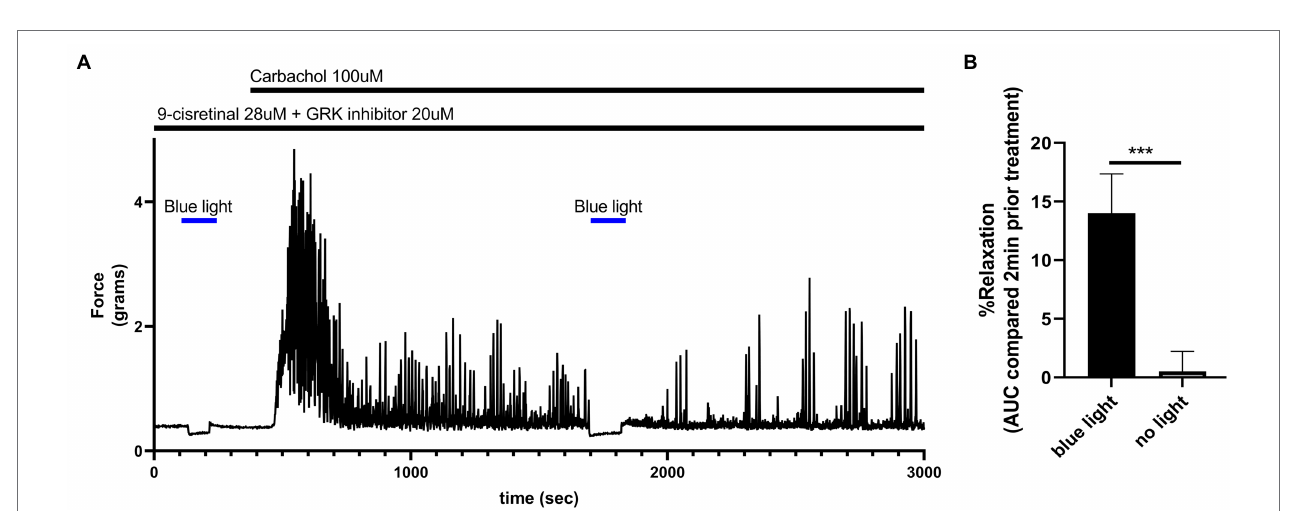
FIGURE 7 | (A) Representative force tracing of colonic rings pretreated with 9- cis retinal 28 μ M + GRK2 inhibitor 20 μ M and constricted with 100 μ M carbachol. Pretreatments depicted by the black bars. Blue bar depicts a 2 min 435 nm blue light treatment. Blue light treatment prior to constriction depicts the effects of blue light on resting tension. The second blue light treatment was to demonstrate the maintenance of post-contractile relaxation. (B) Area under the curve analysis of blue light-induced photorelaxation of rings at resting tension vs. colonic rings that did not get blue light treatment at resting tension. There was significant relaxation with light treatments compared to no light treatments (14 vs. 0.5%, respectively), n = 4, *** p <